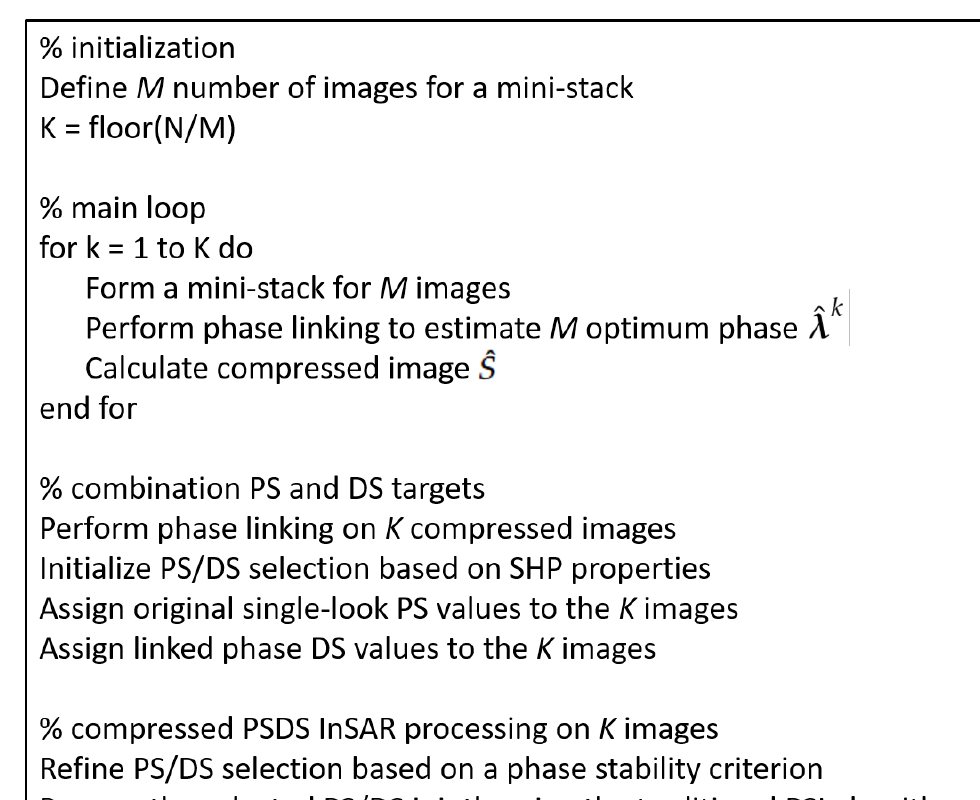
Figure 1. ComSAR: Compressed PSDS InSAR algorithm. The algorithm divides the massive data into many mini-stacks and then compresses